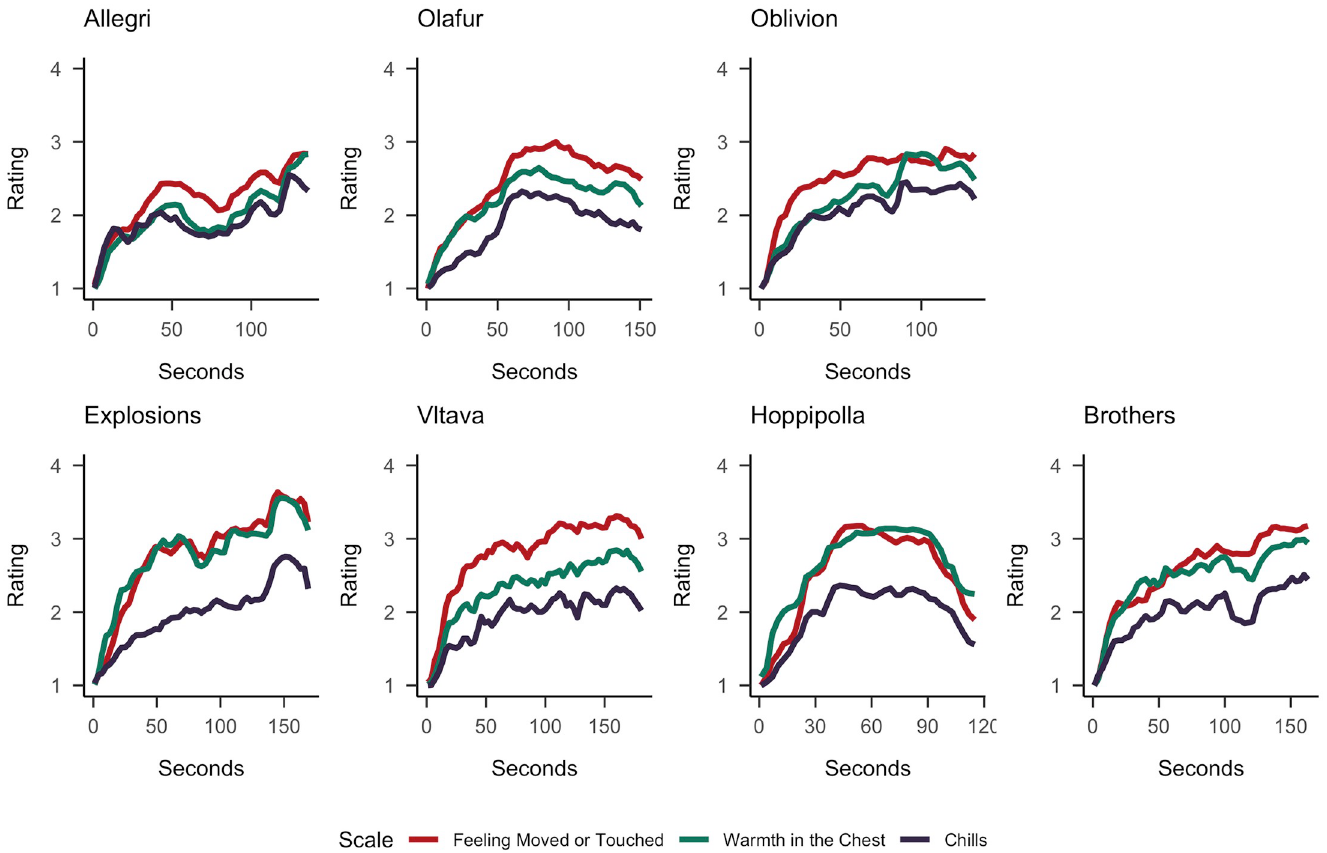
Fig 4. The averaged (non-detrended) continuous ratings of feeling moved or touched , warmth in the chest , and chills for the sadly (Upper Row) and joyfully moving (Lower Row) music excerpts. Ratings were provided on a 5-point scale (ranging from 1 (not at all) to 5 (extremely)) and aggregated in 3s time bins.